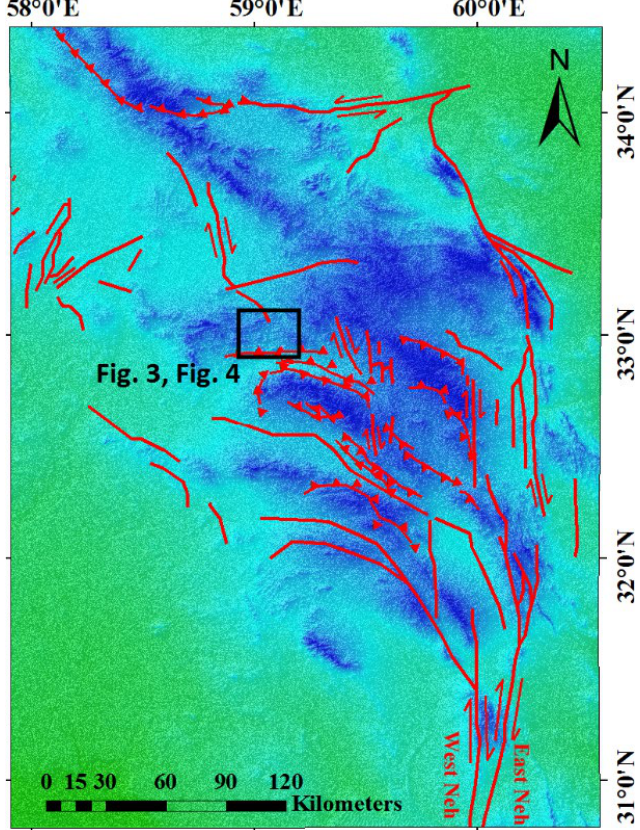
Figure 2. Structural map of eastern Iran (Sistan suture zone) on a shaded relief map, Neh = Nehbandan fault.